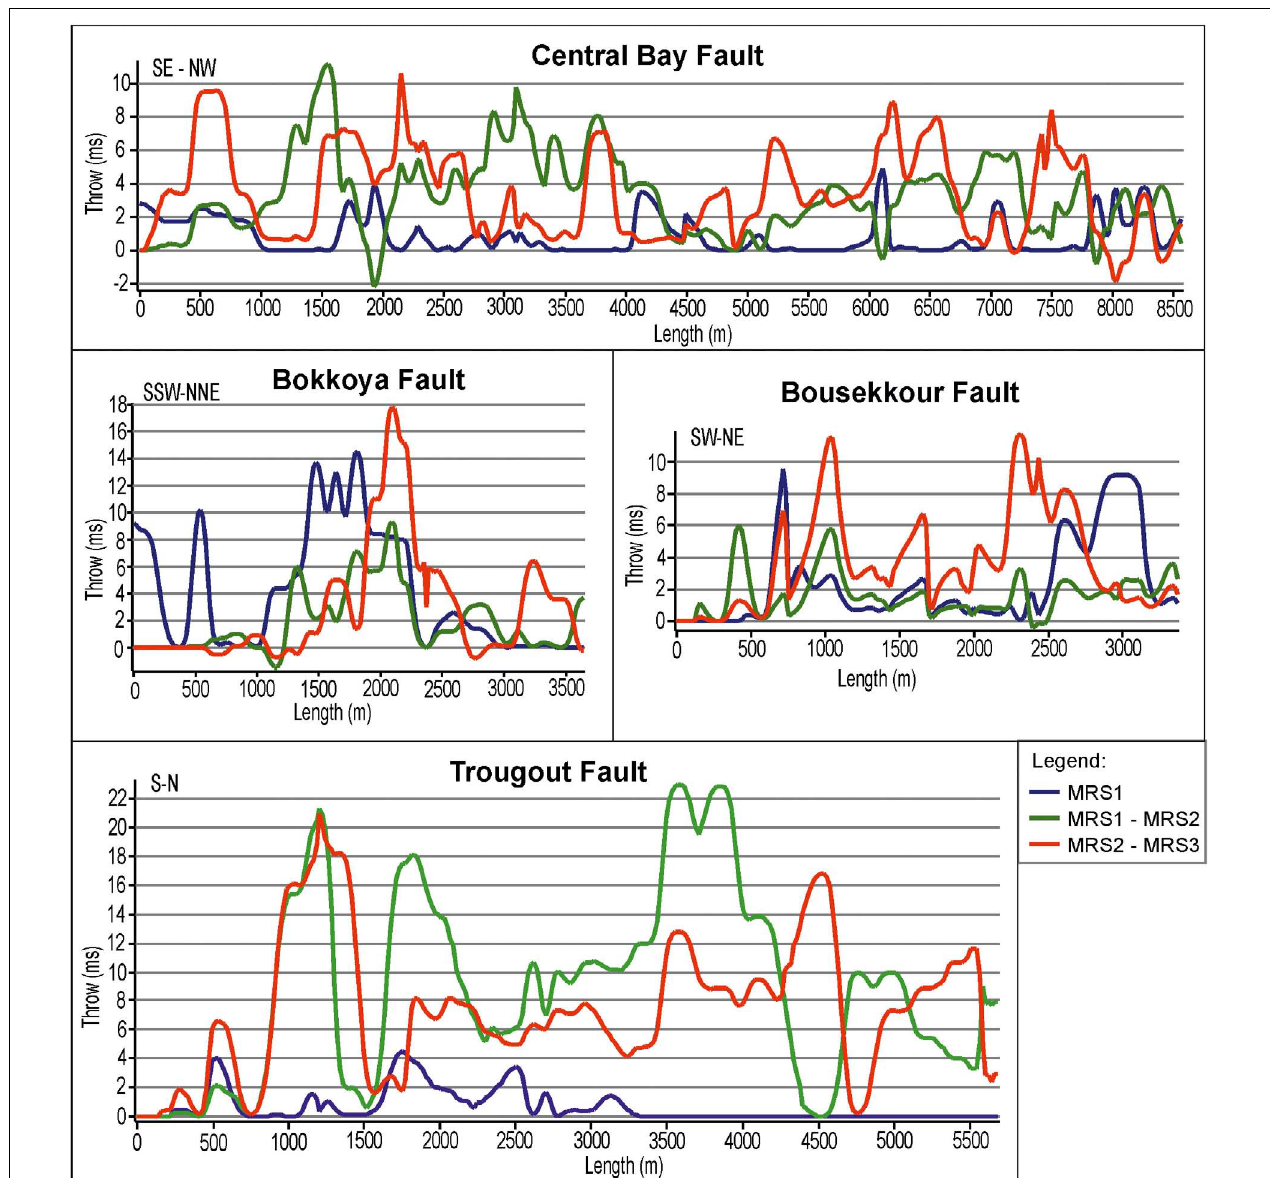
FIGURE 6 | Throw-length profiles obtained from throw maps corresponding to the main faults depicted in Figure 5 . Central Bay Fault profile constitutes a representative example of the normal faults located inside the Bay and corresponds to a group of aligned fault